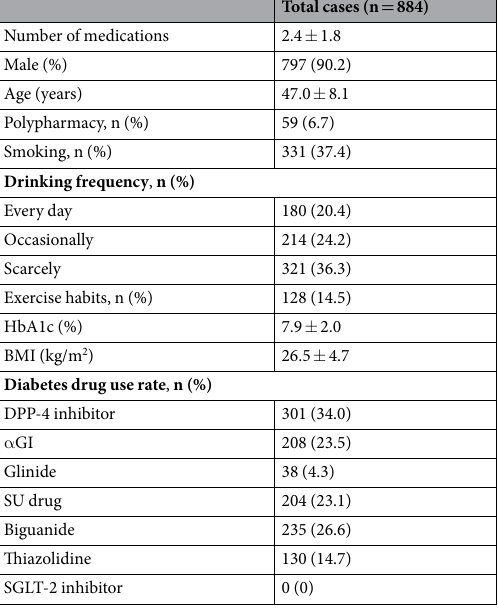
Table 1. Patients’ background characteristics. HbA1c, haemoglobin A1c; BMI, body mass index; DPP-4 inhibitor, dipeptidyl peptidase-4 inhibitor; α GI, α -glucosidase inhibitor; SU, sulfonylurea; SGLT2 inhibitor, Sodium glucose cotransporter 2 inhibitor.